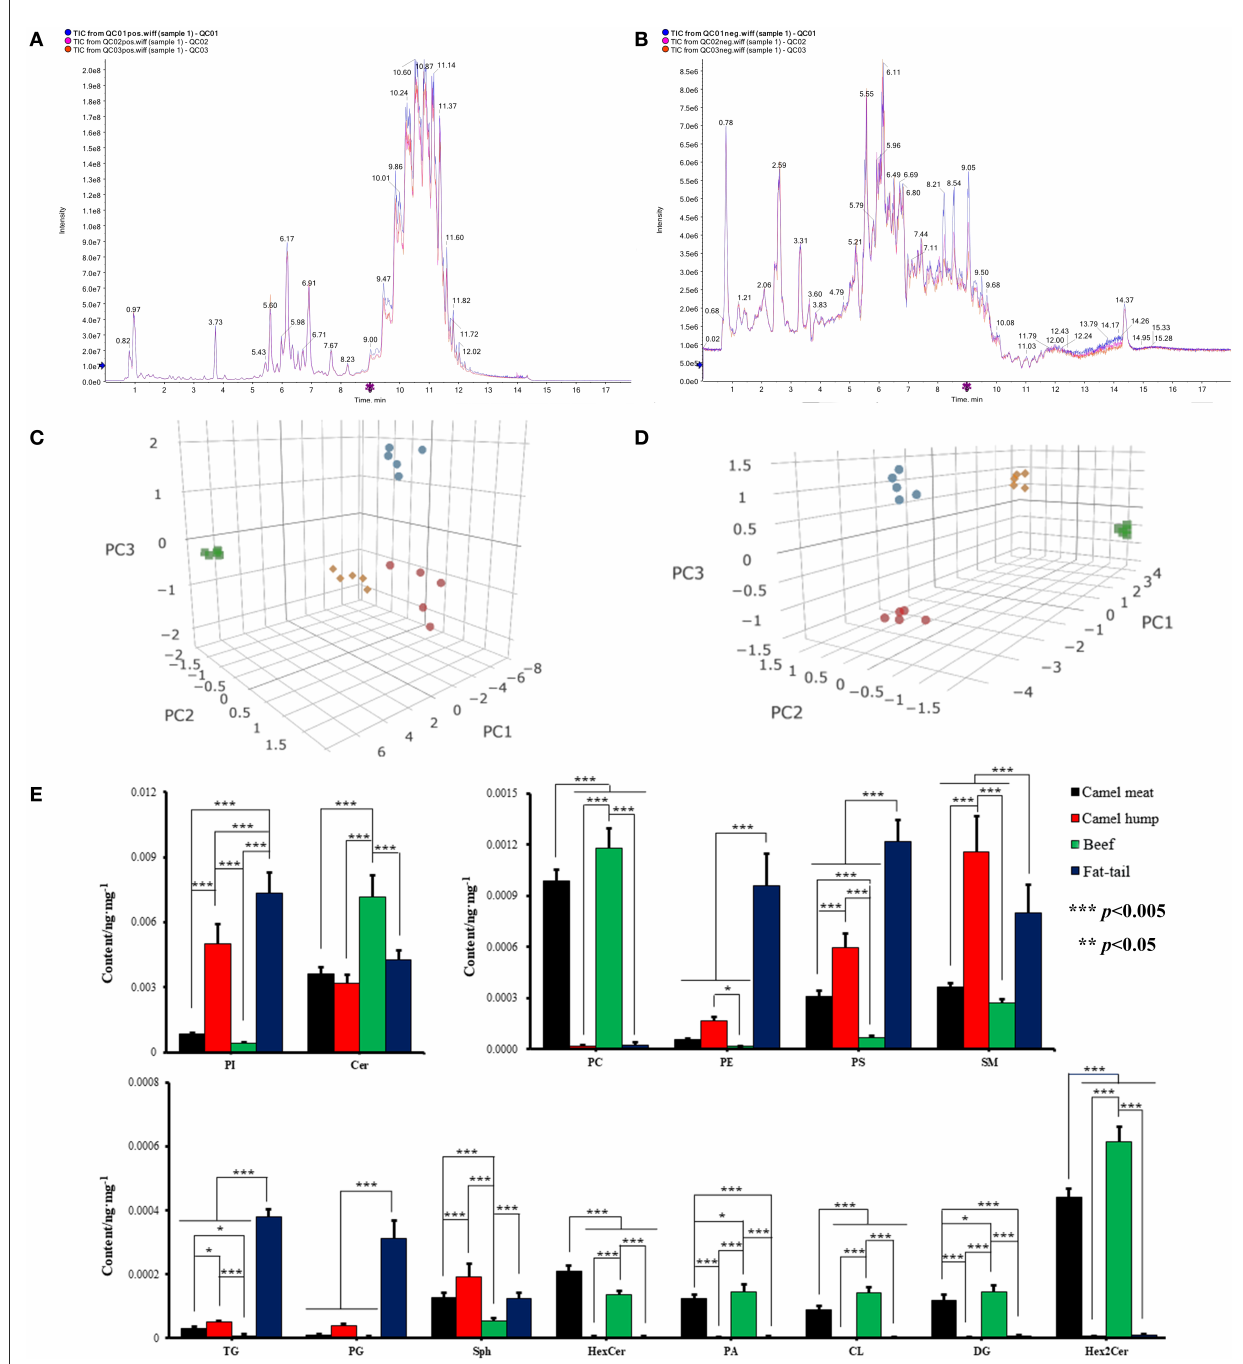
FIGURE2 Representative TICs ESI positive (A) and ESI negative (B) ionization mode of meat. 3D PCA score plots of lipidomics dataset from camel meat (blue circle), camel hump (green square), beef (red circles) and fatty-tails (yellow rhombus) in ESI positive (C) and negative (D) ionization mode ( n = 5). (E) The content of major lipids in different types of meat. PI, phosphatidylinositol; Cer, ceramide; PC, phosphatidylcholine; PE, phosphotidylethanolamine; PS, phosphatidylserine; SM, sphingomyelin; TG, triglyceride; PG, phosphatidylglycerol; Sph, sphinganine; HexCer, hexosylceramide; PA, phosphoric acid; CL, cephalin; DG, diglyceride; Hex2Cer,